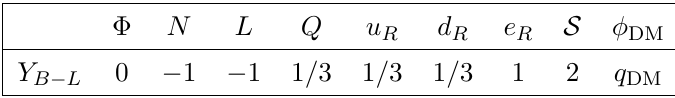
Table 1 . B − L charges for all the fields present in the